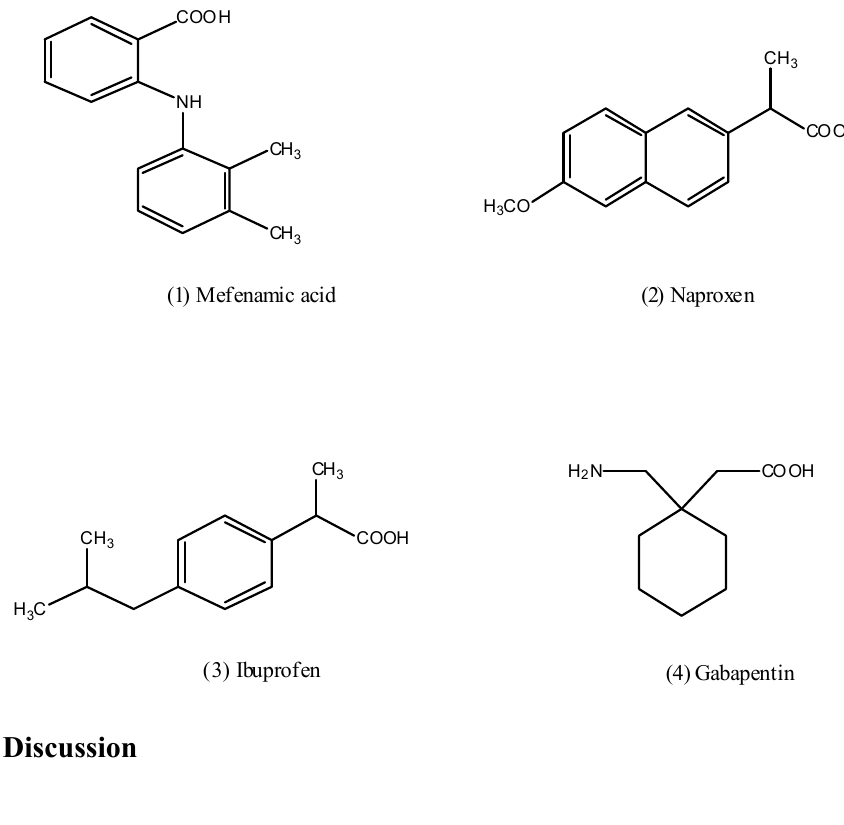
Figure 1. Chemical structures of some NSAIDs and